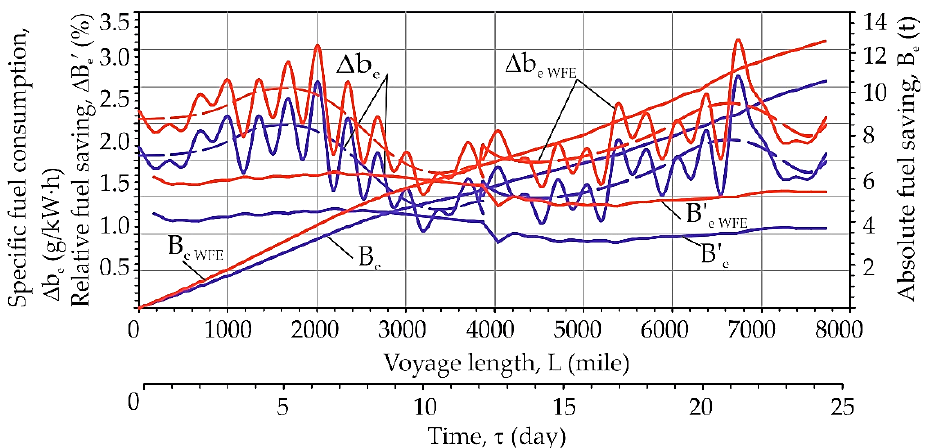
Figure 12. Reduction of specific fuel consumption Δb e , g/(kW h), of low-speed diesel engine, as well as fuel saving in absolute B e , t, and relative B ’ e , %, values as related to the total fuel consumption on the route line Mariupol – Amsterdam – Mariupol (22 July 2019 – 3 August 2019): Δb e , B e , and B ’ e — convention oil fuel; Δb e WFE , B e WFE , and B ’ e WFE — WFE.